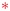
The correlation between a bulky X residue in the GXDS motif and the residue of helix III that packs into the protein core.The residue equivalent to AcpP:A59, which packs into the protein core, is indicated by *. The length of the sequence logo is that of the alignment including gaps, which does not correspond to the length of the template sequence; thus the numbering does not correspond to that used in the text, which follows that of the PDB entries. Empty positions in the logo correspond to too few residues in the sequence alignment for logo construction. Sequence logos were built on a) 27 unique type I ACP sequences from a PHI blast search with a GLDS motif and the rat FAS sequence. Searches were restricted to mammals and fungi and results are all part of larger multi-domain proteins. b) 316 unique type II ACP sequences from a PHI blast search with a GADS motif and the AcpP sequence. The search was restricted to bacterial sequences and produced only discrete ACP sequences. c) 101 unique type I ACP sequences from a PHI blast search with a GLDS motif and the ACP3 sequence. The search was restricted to bacterial sequences and returned ACPs from multi-domain contexts. d) 449 unique type II ACP sequences from a blast search with the actinorhodin ACP sequence. The search was restricted to actinomycetes only and produced type II-like discrete sequences.